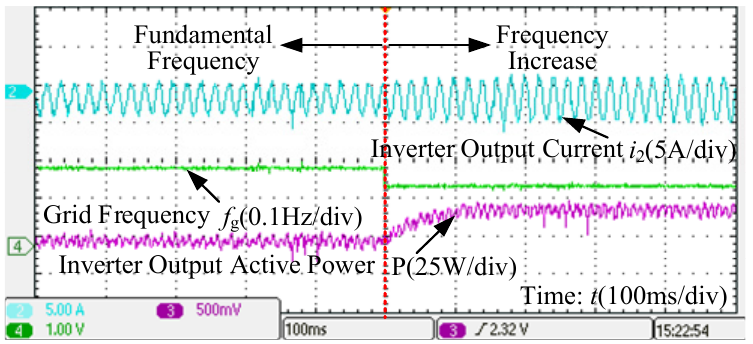
Figure 19. Inverter output current and output active power waveform when the grid frequency rises.